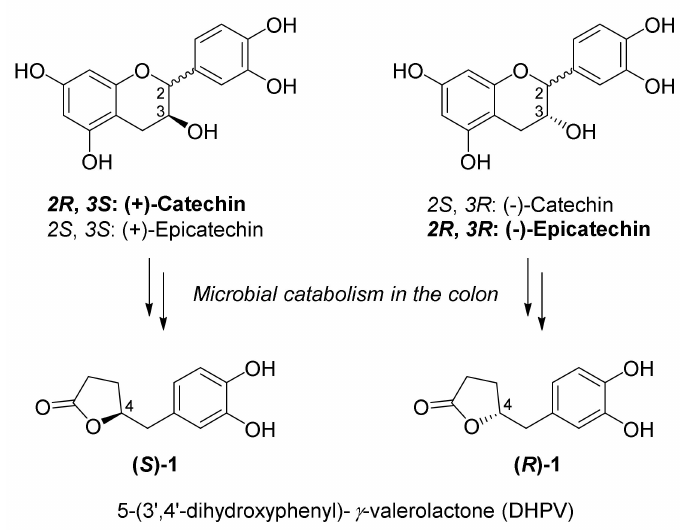
Figure 1. Structures of catechins and their metabolite